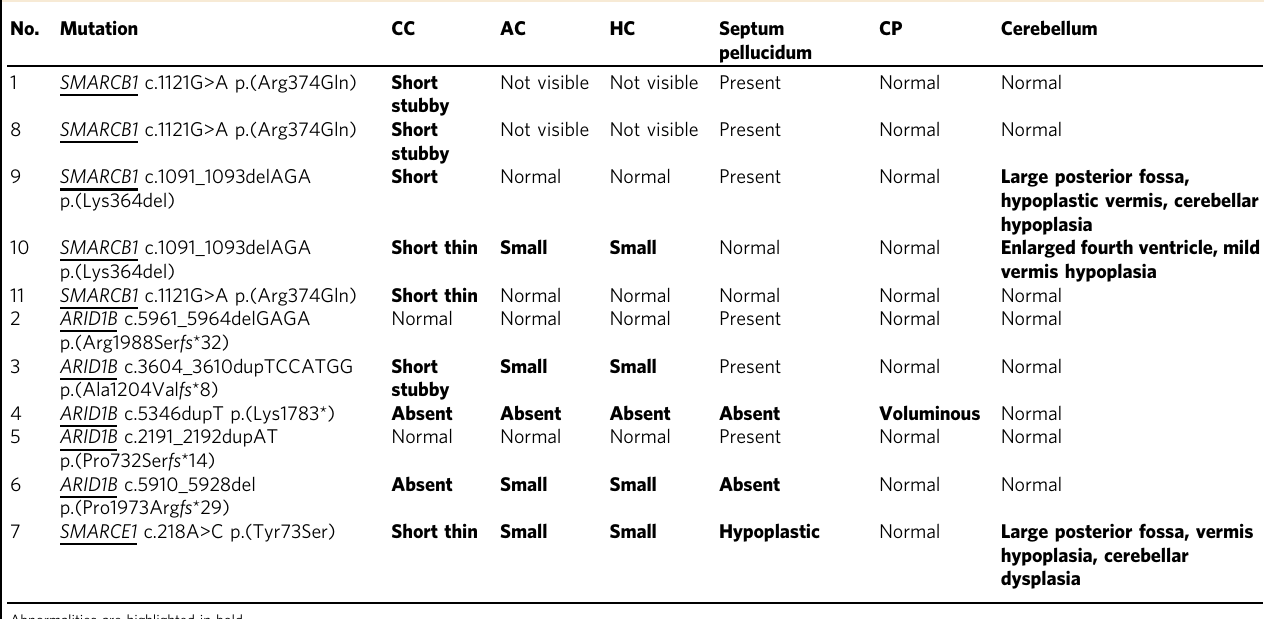
Table 1 Brain MRI fi ndings in CSS individuals No.